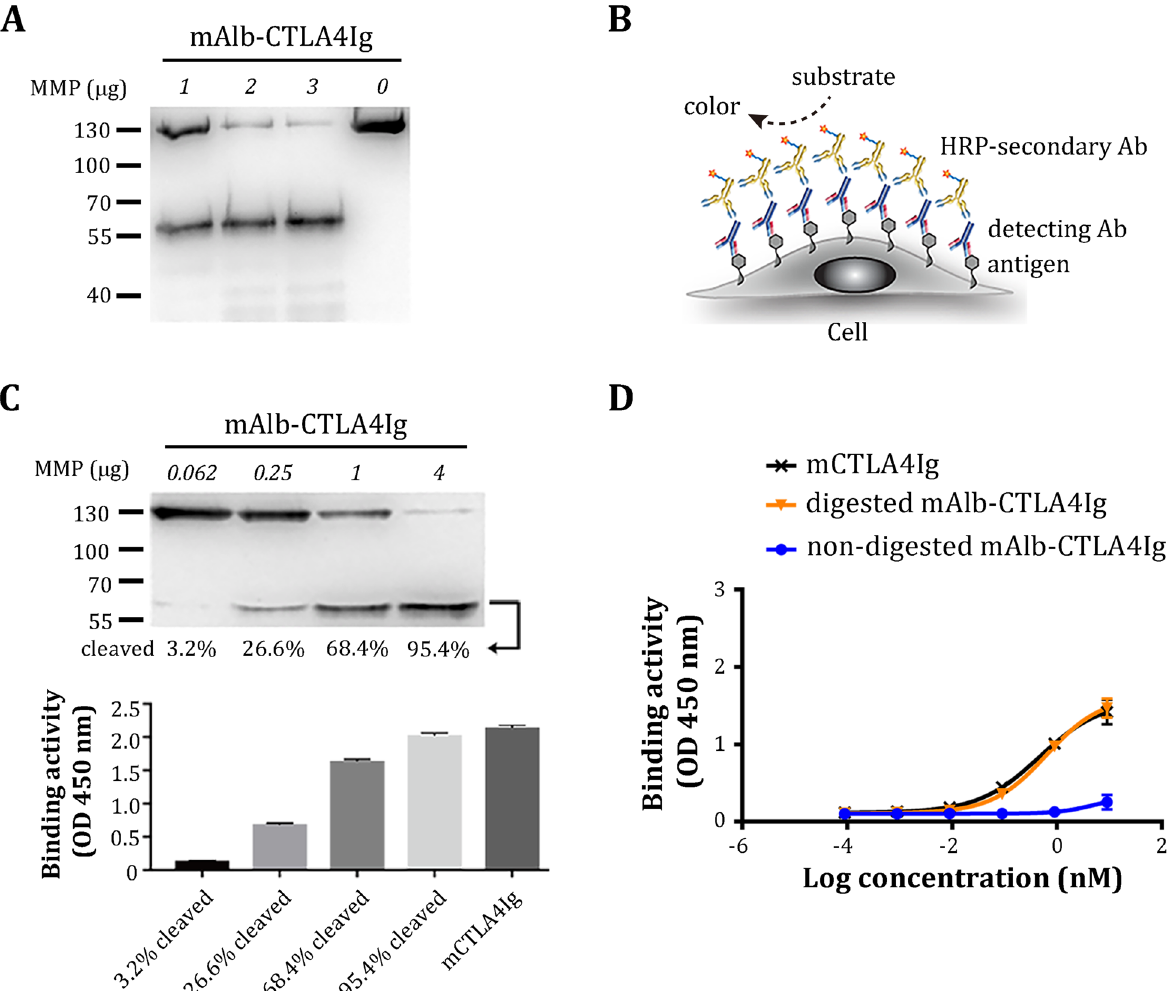
Fig. 3 Binding activities of mAlb‑CTLA4Ig before and after MMP2/9 digestion. A mAlb‑CTLA4Ig was digested with the indicated amount of MMP2/9 and then analyzed by western blot using an anti‑mouse Fcγ antibody. Note that the major bands after digestion correspond to the size of conventional mCTLA4Ig (~ 55 kDa under reducing conditions). B Schematic representation of the cell‑based ELISA used in the current study. C mAlb‑CTLA4Ig were subjected to varying degrees of digestion by MMP2/9. Part of the digestion was analyzed by western blot to determine